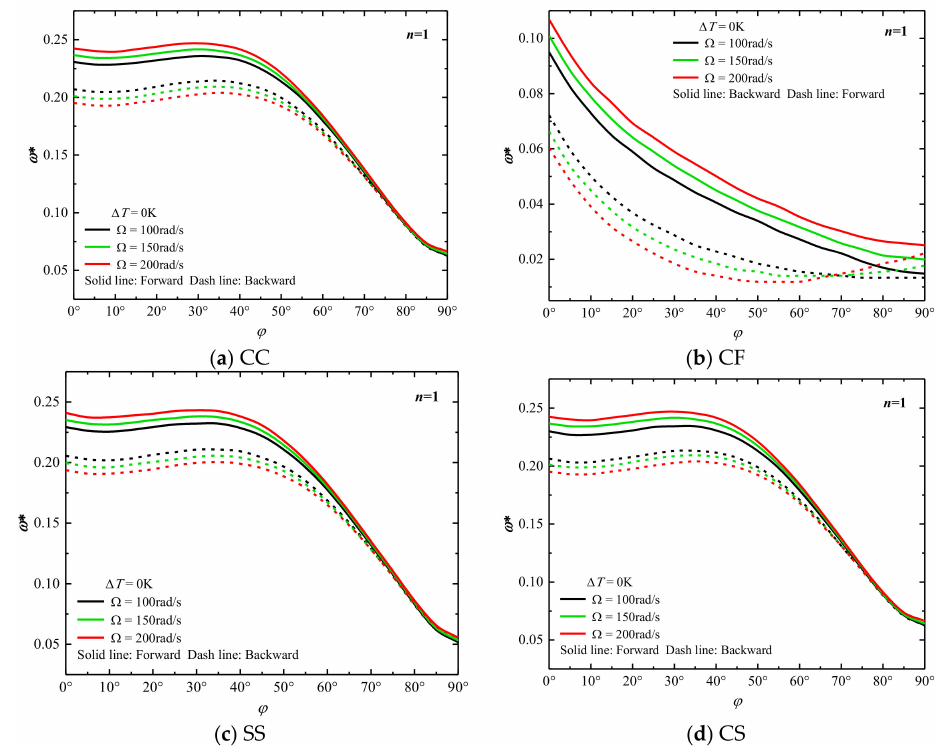
Figure 4. Variation of dimensionless frequencies ω ∗ of rotating laminated combined conical- cylindrical shell with different semi-vertex angle ( m = 1).